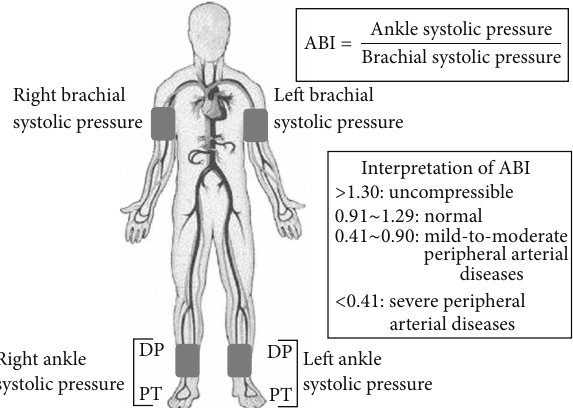
Figure 2: The electric analog circuit model of the entire cardiovas- cularsystem.Eachcomponentiscomprisedofacompliancevariable C , a resistance 𝑅 , and an inductance L (1: aorta (a); 2: thoracic and abdominal aortae (l); 3/7: left/right femoral artery (afl/afr); 4/8: left/right popliteal artery (apl/apr); 5/9: left/right posterior tibial artery (atl/atr); 6/10: other left/right lower limb arteries (all/alr); 11/14: left/right brachial artery (abl/abr); 12/15: left/right radial artery (arl/arr); 13/16: left/right ulnar arteries (aul/aur); 17: carotid artery (ac); 18/19: left/right lower limb capillaries (alpl/alpr); 20/21: left/right upper limb capillaries (aupl/aupr); 22: brain (acp); 23/24: left/right lower limb veins (vll/vlr); 25/26: left/right upper limb veins (vul/vur); 27: jugular veins (vc); 28: system vena (ve); 29: C lv represents the compliance of the left ventricular). The effects of inertia for veins are not considered in this